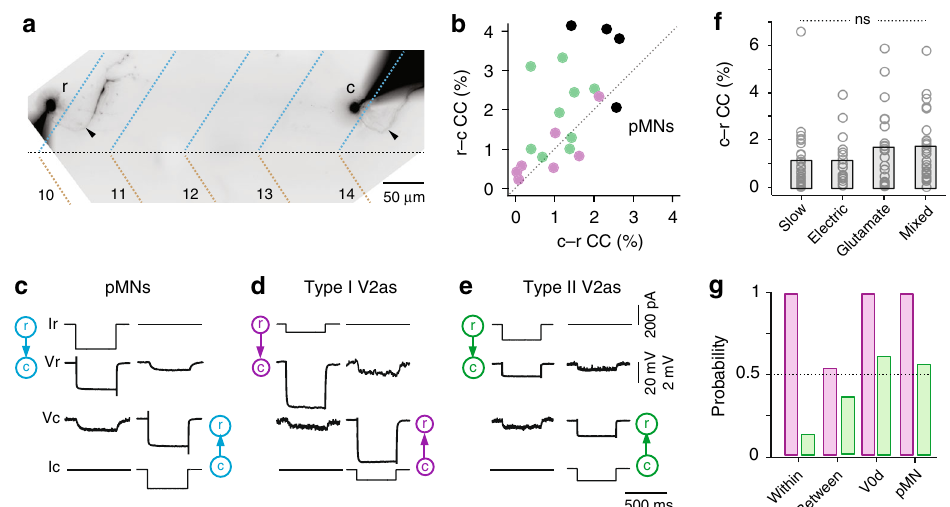
Fig. 7 Electrical coupling unrelated to fast synaptic connectivity. a Contrast inverted fl uorescent images of fi lls post-recording from rostral and caudal epaxial primary motor neurons separated by four body segments, whose coupling is illustrated in panel c. Filled arrowheads indicate axon innervating the dorsal, epaxial muscle (blue dashed lines), which is separated from ventral, hypaxial muscle (brown dashed lines) by the horizonal myoseptum (black dashed line). Muscle segments are numbered. b Quanti fi cation of coupling coef fi cients (CC) within type I V2as (purple, n = 7 pairs), type II V2as (green, n = 9 pairs) and primary motor neurons (black; n = 2 epaxial/epaxial, n = 1 hypaxial/hypaxial, n = 1 epaxial/hypaxial) in both descending (rostro-caudal, r-c) and ascending (c-r) directions. All recordings were performed between neurons separated by 2 – 4 body segments. Source data are provided in a Source Data fi le. c Paired recordings from epaxial motor neurons in panel a illustrate coupling revealed by hyperpolarizing current steps in both descending (r-c) and ascending (c-r) directions, as indicated by cartoons. V voltage, I current. d As in panel c , but coupling between type I V2a neurons. e As in panel c , but coupling between type II V2a neurons. f Quanti fi cation of the coupling coef fi cient measured in the ascending direction (caudo-rostral) for V2a connections to all post-synaptic targets that are slow, electric, glutamatergic (glut.) or mixed. ns not signi fi cant following Kruskal Wallis ANOVA for comparisons across multiple samples (H(3) = 5.6, p = 0.131, n = 104). Bars represent means. Source data are provided in a Source Data fi le. g Quanti fi cation of the probability of fi nding a connection from type I V2a neurons (purple) and type II V2a neurons (green) within types (type I V2a, 12/12; type II V2a, 2/15), between types (type I to type II V2a, 7/13; type II to type I V2a, 5/14), to V0d neurons (type I V2a, 11/11; type II V2a, 10/17) and to primary motor neurons (type I V2a, 38/38; type II V2a, 40/71)